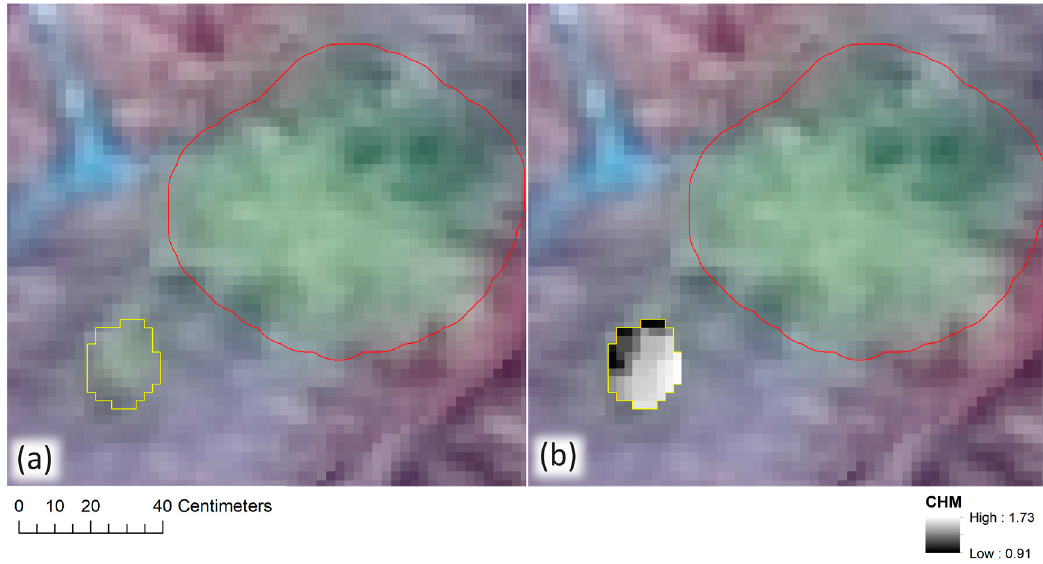
Figure 13. Predicted ITC polygon (yellow) located beneath a deciduous overstory whose remote height measurement overestimated its corresponding field measurement. ( a ) displays the polygon in true colour, while ( b ) shows CHM values within the polygon. The greatest CHM values within the polygon are located towards its bottom and right-hand borders, where green values in the true colour image are relatively low.